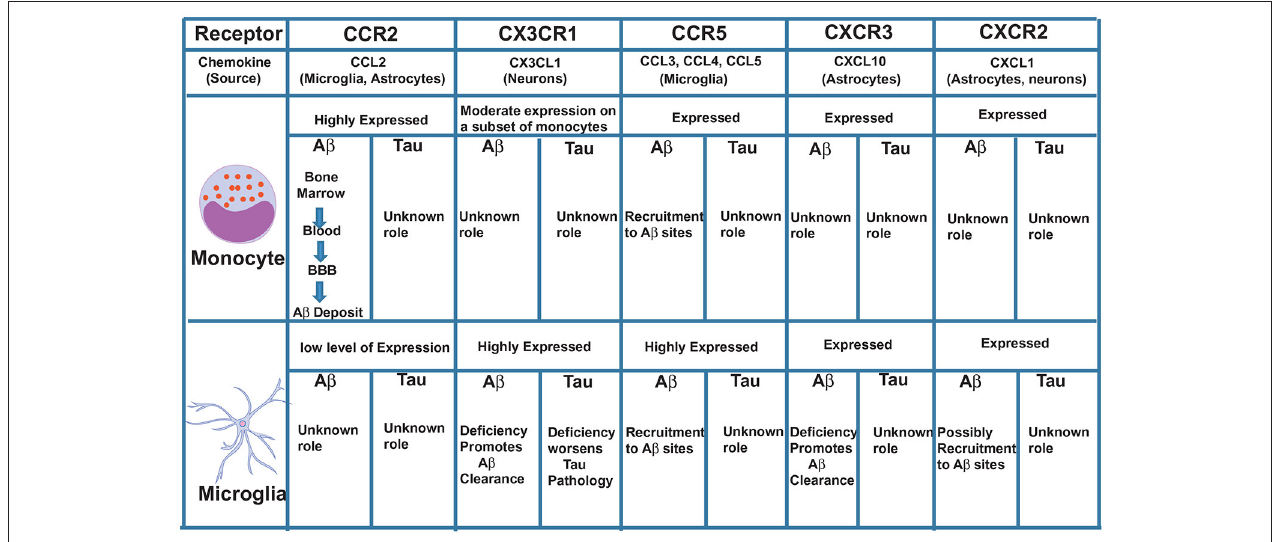
FIGURE 1 | Major chemokine receptors expressed on monocytes and microglia and their possible roles in A β and Tau